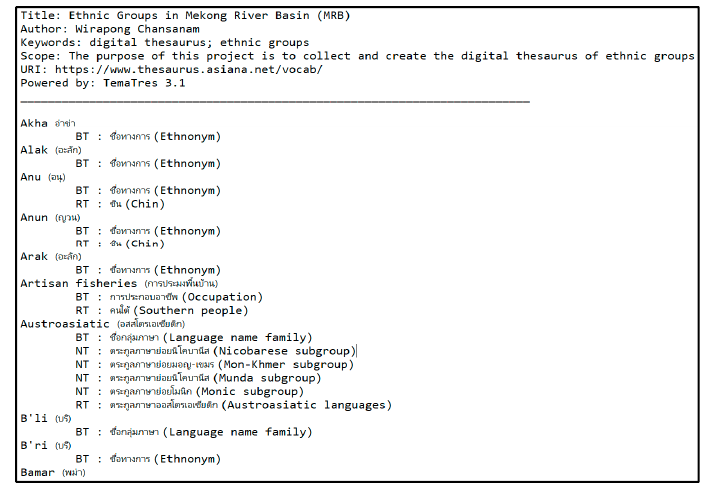
Figure 4. Example of the thesaurus of ethnic groups in the MRB.